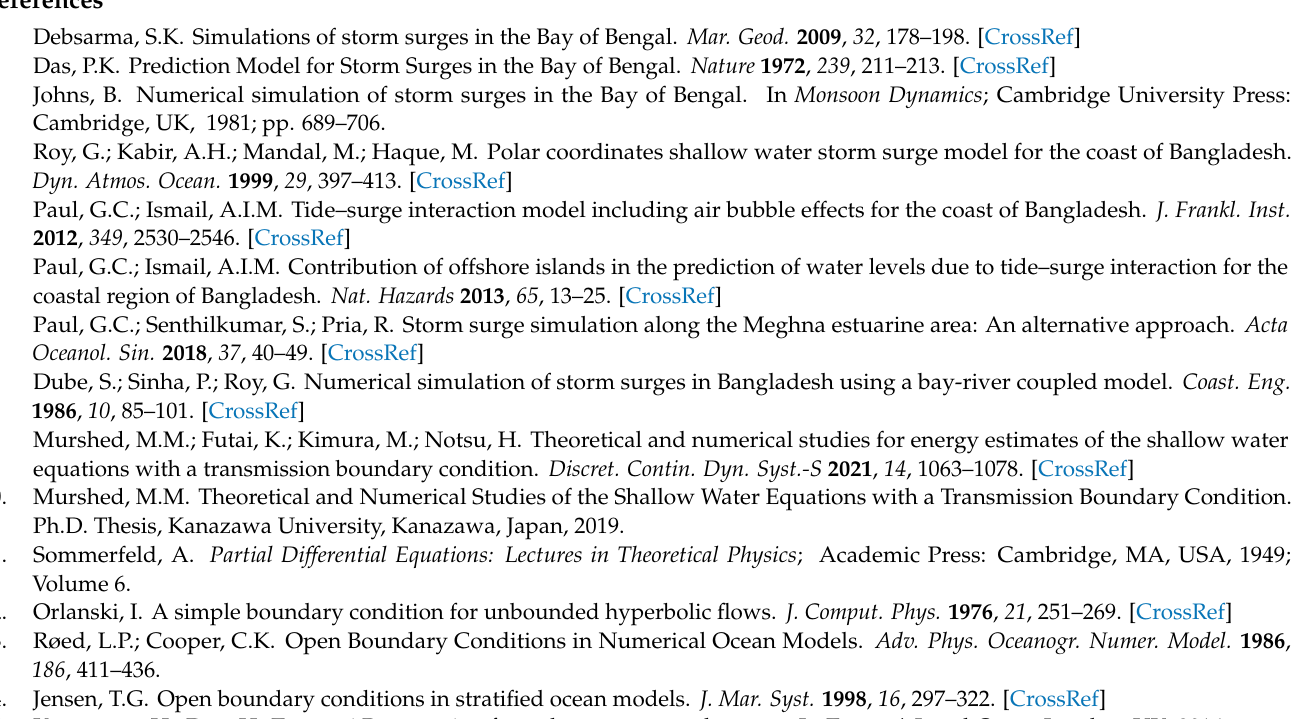
for different boundary conditions for Case II (the Bay of h